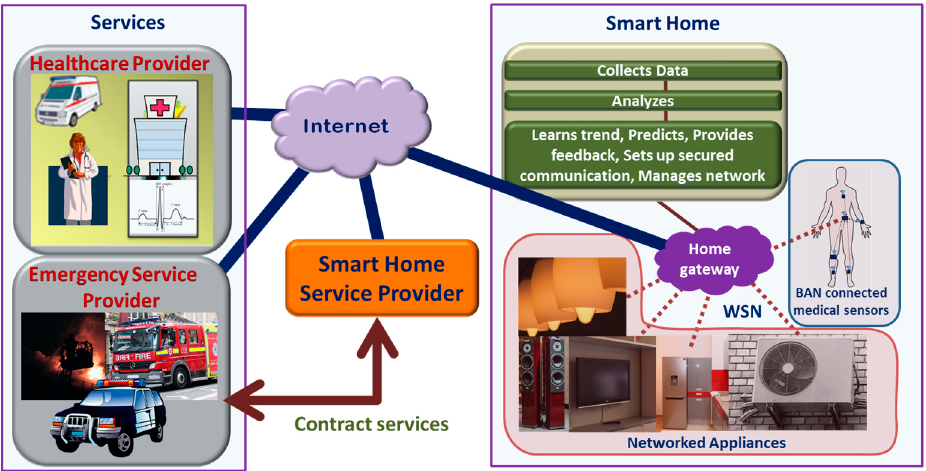
Figure 6. Schematic diagram of a smart home showing the network among different stakeholders.